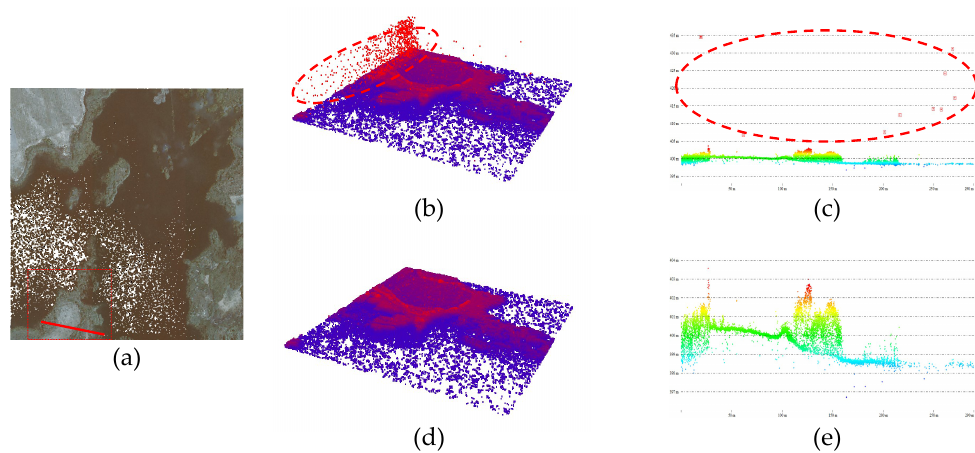
Figure 12. Visualization of the effect of the multiple denoising in the water area using our proposed approach. ( a ) overview of the water area; ( b ) three-dimensional view after the first denoising; ( c ) profile after the first denoising; ( d ) three-dimensional view after the second denoising; ( e ) profile after the second denoising.